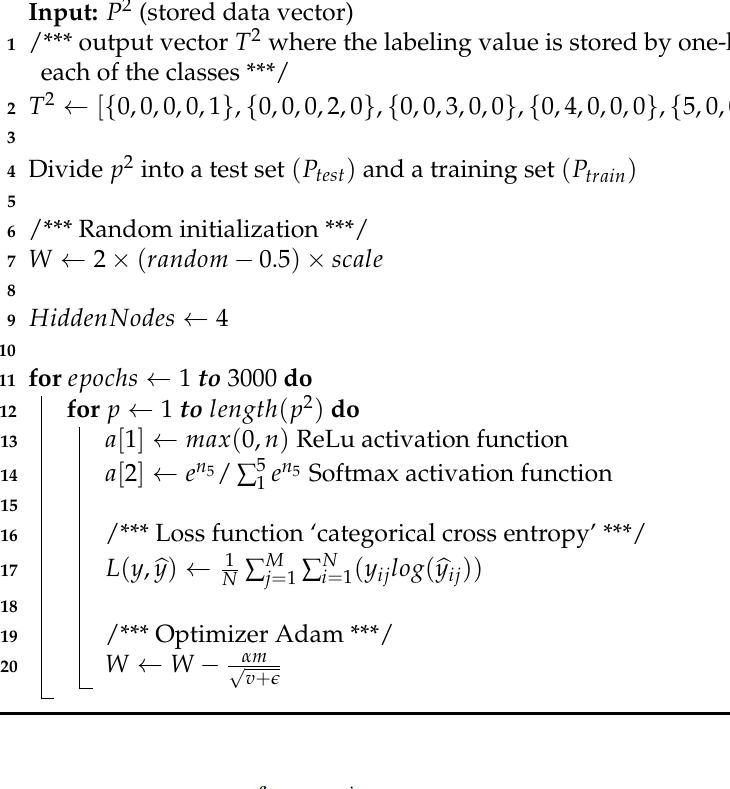
Algorithm 2: Neural network pseudocode.